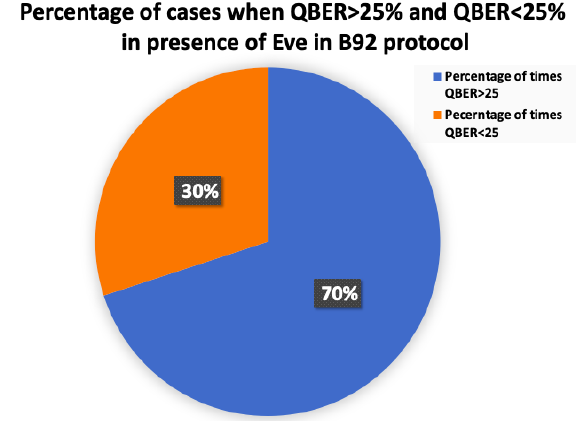
Figure 12. Percentage of cases when QBER is greater and less than 25% in the presence of an Eve in B92 protocol.